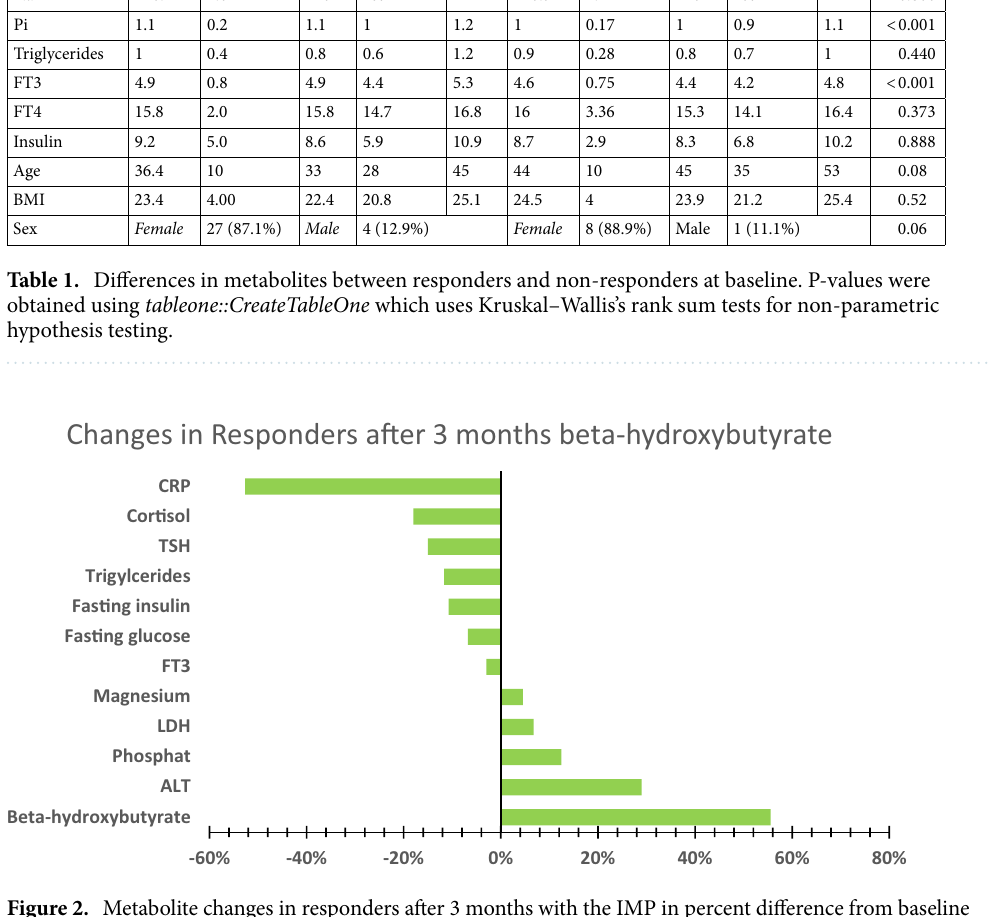
Figure 2. Metabolite changes in responders after 3 months with the IMP in percent difference from baseline values. (n =